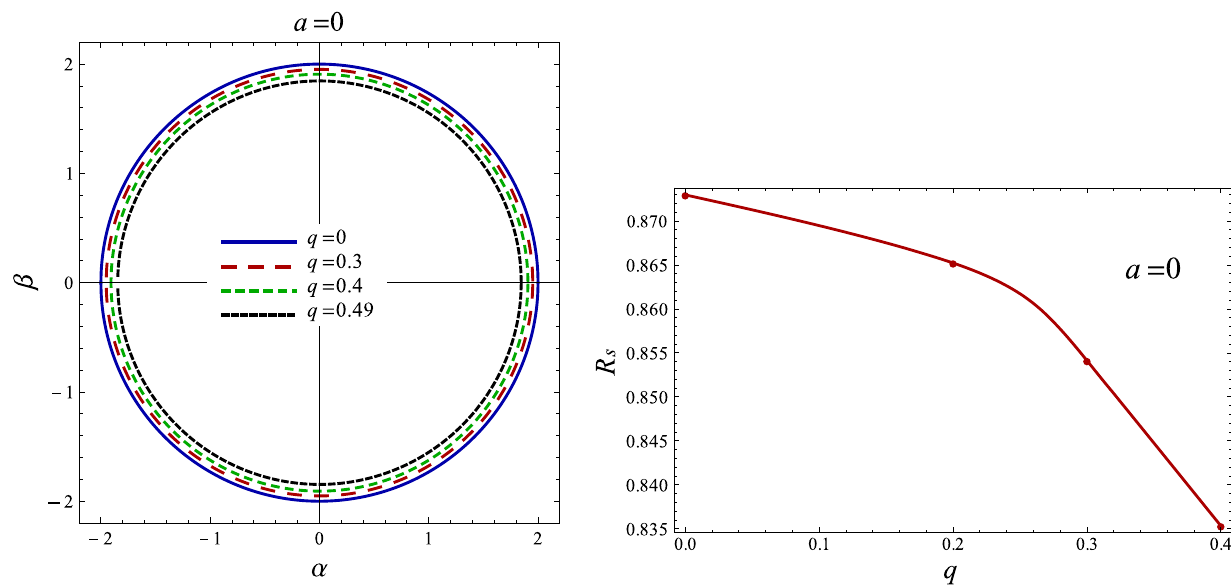
Fig. 4 Plot showing the shapes of black hole shadow cast by EMCS black hole with inclination angle θ 0 = π/ 2 and corresponding observable R s , for different values of charge q for the nonrotating case ( a =